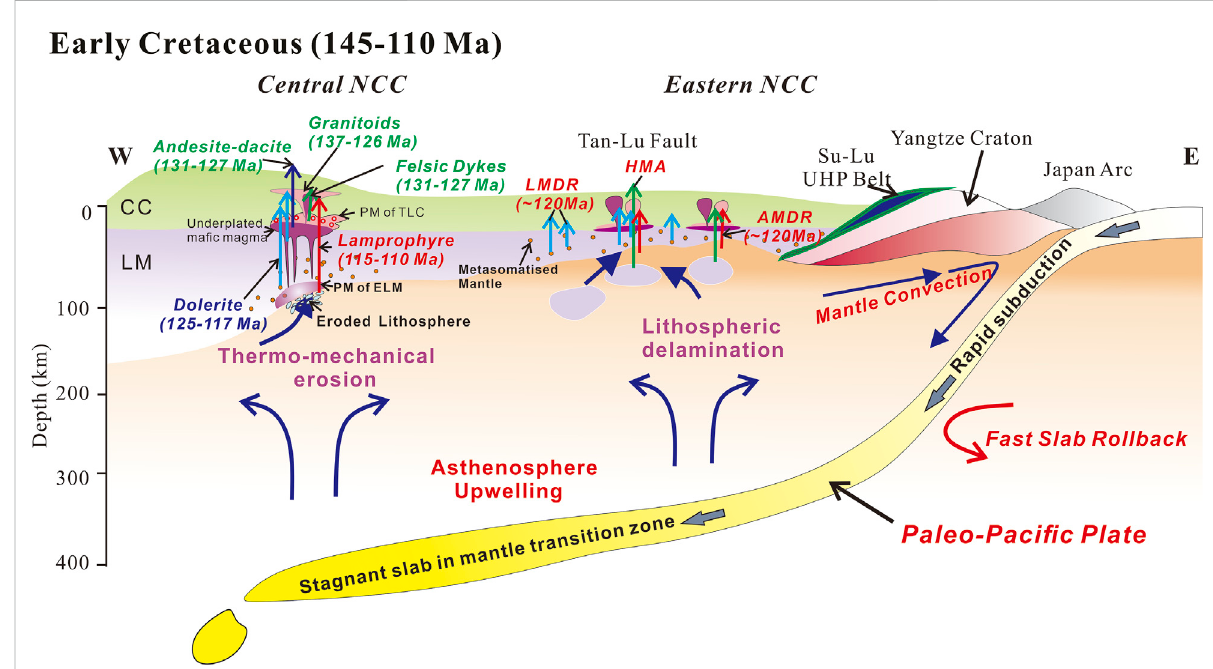
FIGURE 10 Schematicplatetectonicmodel(nottoscale)toexplainthelithosphericdestructionoftheNorthChinaCratonduringEarlyCretaceousthrough thermal-mechanical erosion and lithospheric delamination. Detailed discussions are in the text. AMDR, asthenospheric mantle-derived rocks; CC, continental crust; ELM, enriched lithospheric mantle; HMA, high-Mg adakites; LM, lithospheric mantle; LMDR, lithospheric mantle-derived rocks; TLC, thickened lower